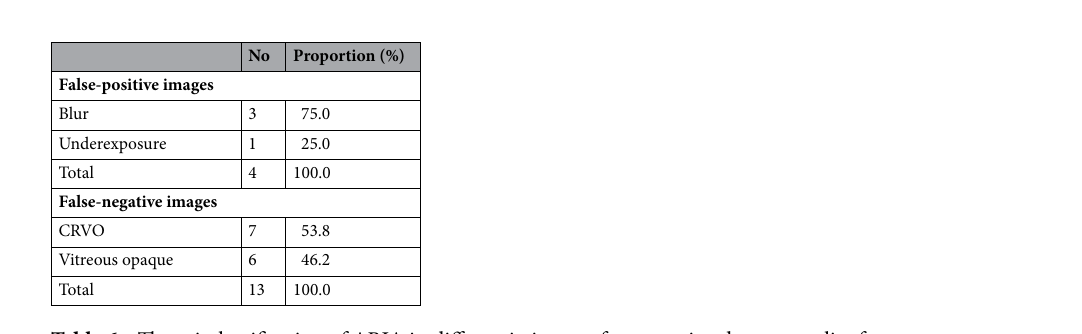
Table 6. The misclassification of ARIA in differentiating artefact-associated-poor-quality from eye- abnormality-associated-poor-quality. CRVO central retinal vein occlusion.